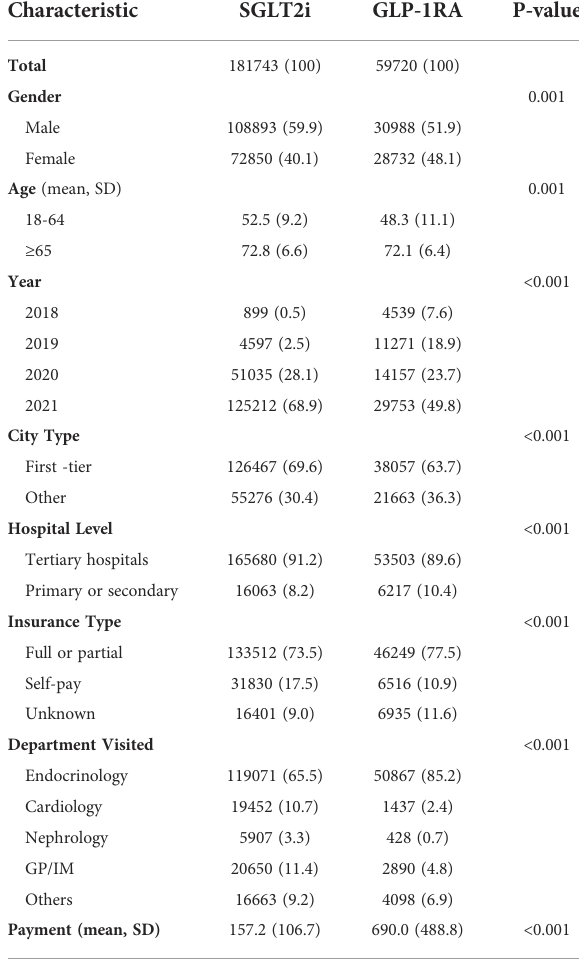
Table 1 Baseline characteristics of the study